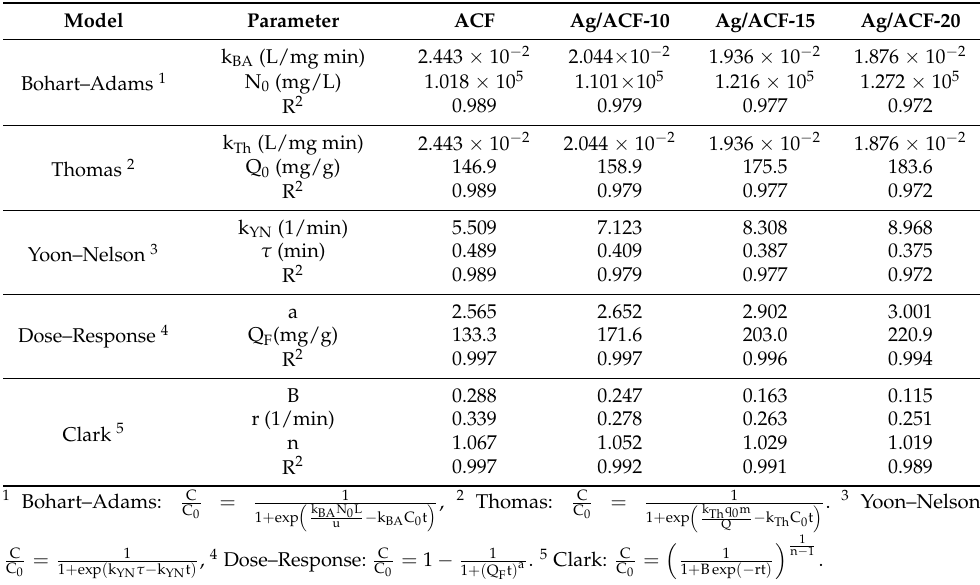
Table 4. Breakthrough models used in this study and their calculated parameters.